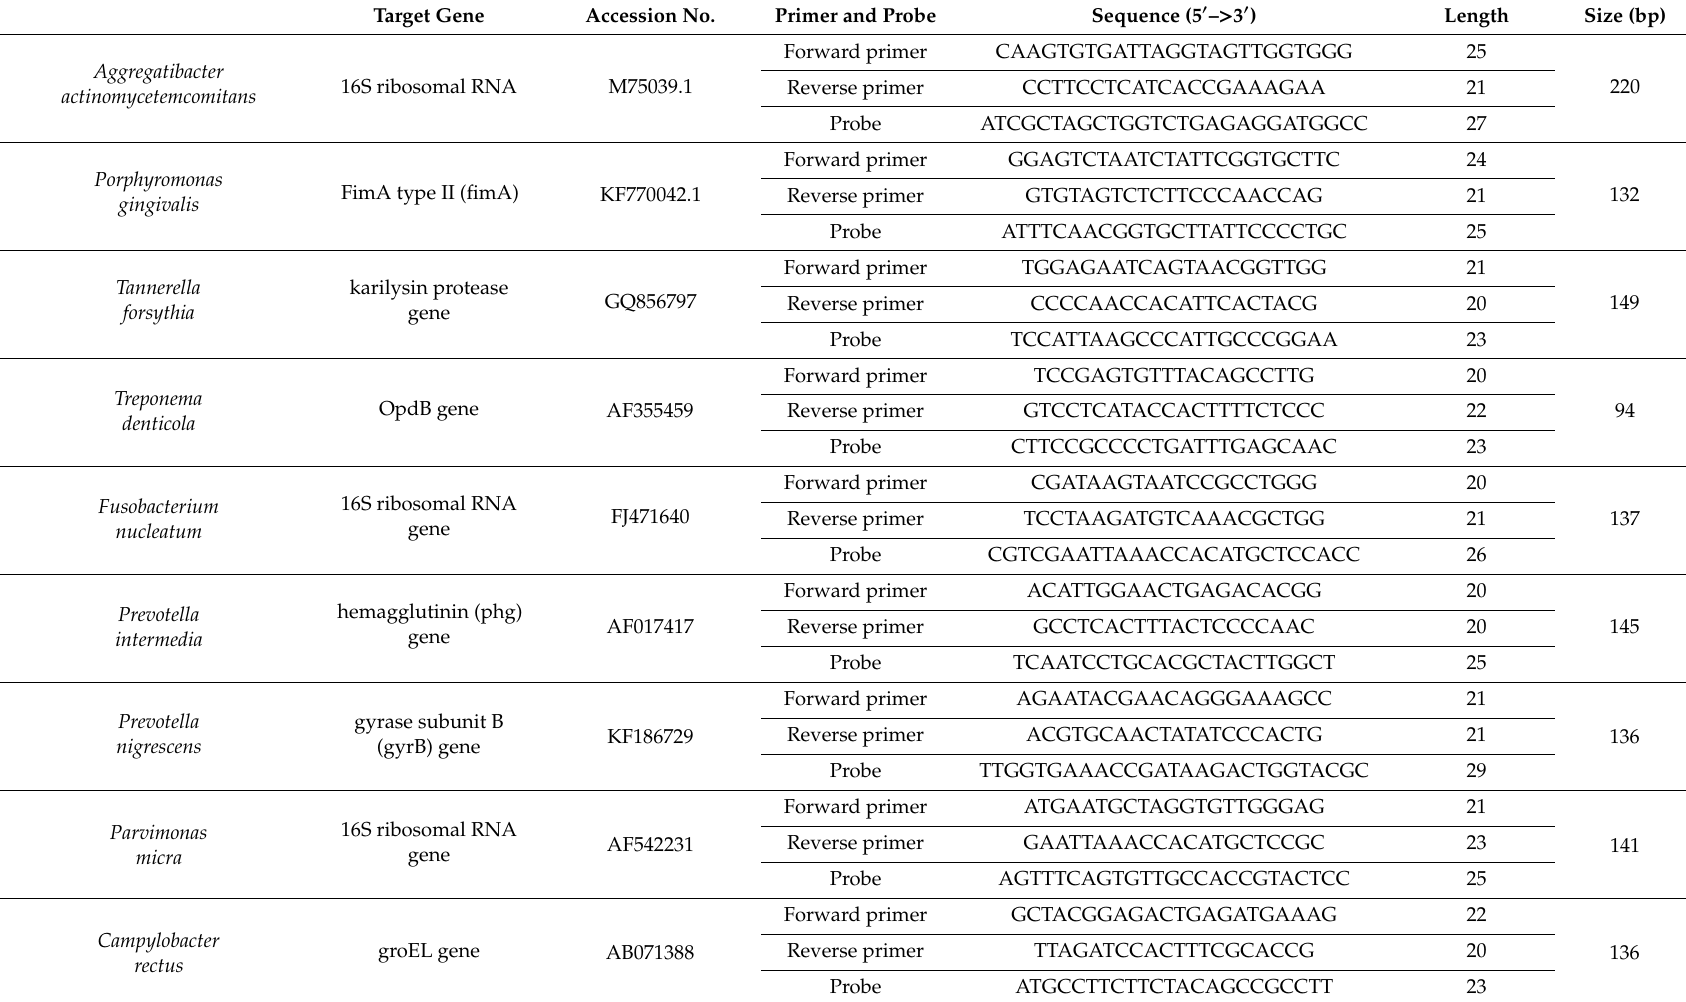
Table 1. Sequence of primers / probes used in